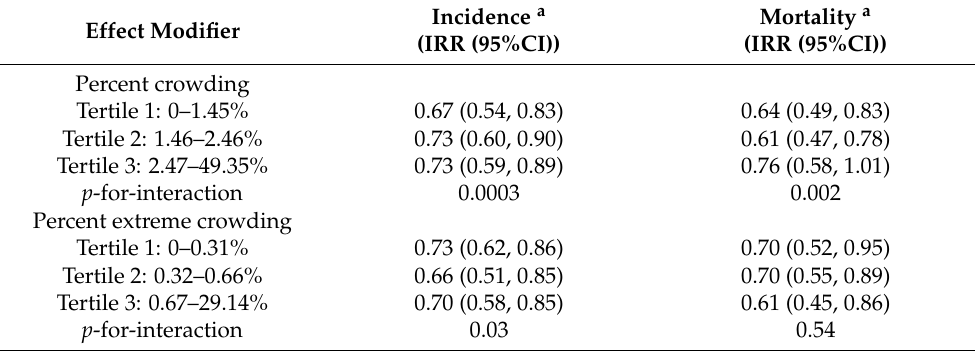
Table 2. Effect modification of the association of each one-unit increase in county-level objective social distancing on the risk of county-level COVID-19 incidence or mortality in the United States through 29 April